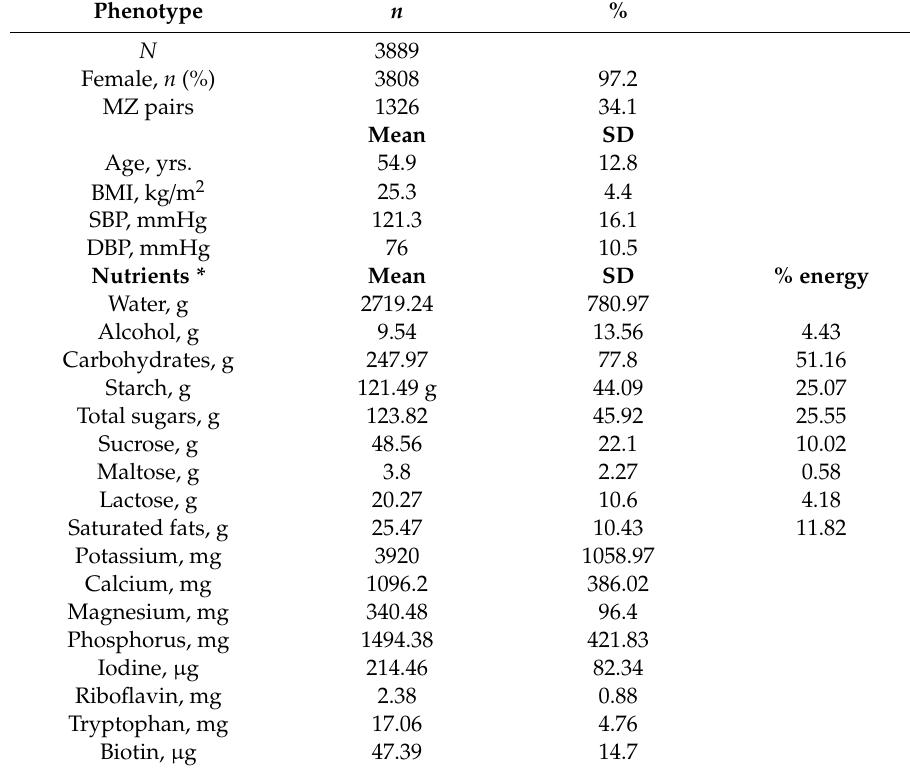
Table 1. Characteristics of the study population ( n =